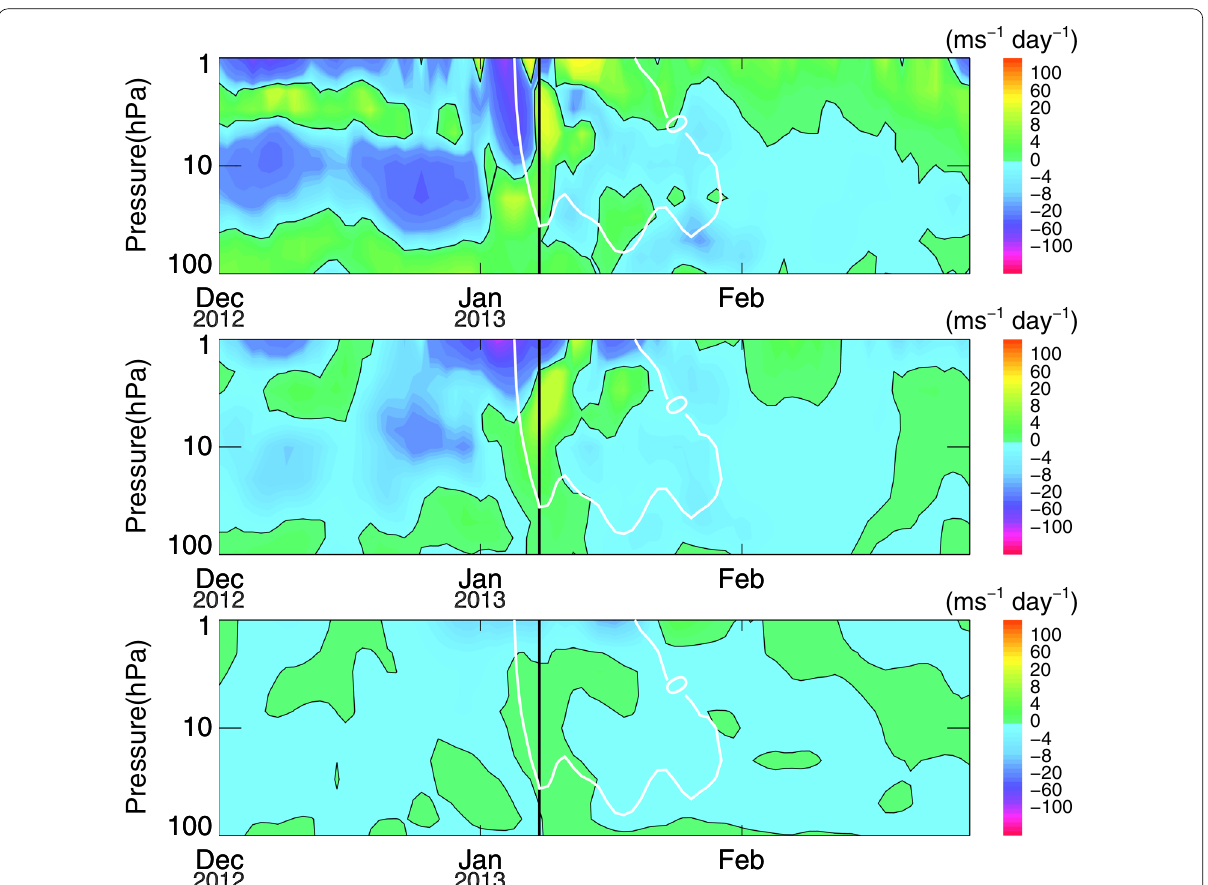
Fig. 11 As in Fig. 10, but for the D F from quasi-stationary PWs (top), interaction between W1 Q16DW and quasi-stationary PWs (middle), and W1 Q16DW (bottom) at 50–80 ◦